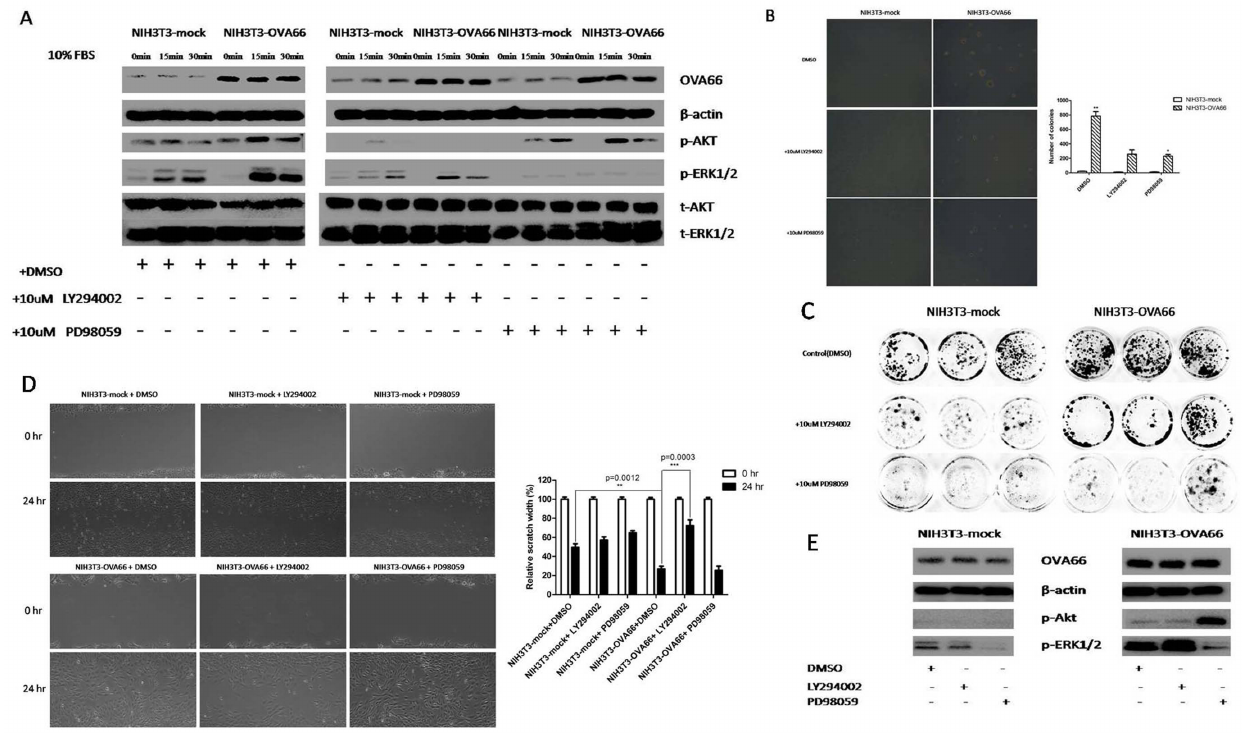
Figure 6. AKT and ERK1/2 phosphorylation. A. Analysis of serum-stimulated phosphorylation of AKT and ERK1/2 as well as total AKT and ERK1/2 protein levels in NIH3T3-flagOVA66 and NIH3T3-mock cells pretreated with control vehicle DMSO, 10 m M LY294002 and 10 m M PD98059 were analyzed by western blotting using actin as a loading control. B. Detection of colony formation in soft agar seeded with NIH3T3-mock and NIH3T3- flagOVA66 cells treated with DMSO, 10 m M LY294002 and 10 m M PD98059. Magnification: 100 6 , the histogram shows quantification of cell colonies in soft agar. The data are represented as mean 6 SEM (n=3), * P # 0.05, ** P # 0.01. C. 400 cells per well were seeded in a 6-well plate for 24 h, followed by treatment with DMSO, 10 m M LY294002 or 10 m M PD98059 for 10 days. Cells were then stained with crystal violet for imaging cell clones in plates. D. Representative wound healing assay images at 0 and 24 hours and the quantification of the relative scratch width after 24 h. Magnification: 100 6 . Data are mean 6 SEM. **P # 0.01, ***P # 0.001. E. Cells of each group of the wound healing assay after 24 h were lysed and the total proteins were analyzed by western blotting.